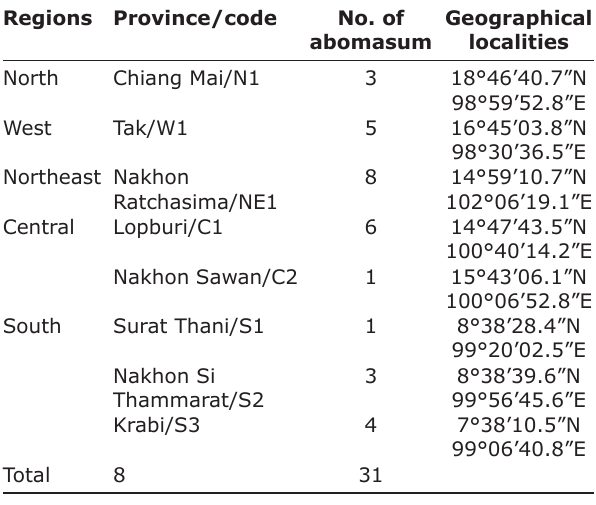
Table-1: Haemonchus contortus adult worms were collected from goats in eight city abattoirs from five different regions of Thailand.